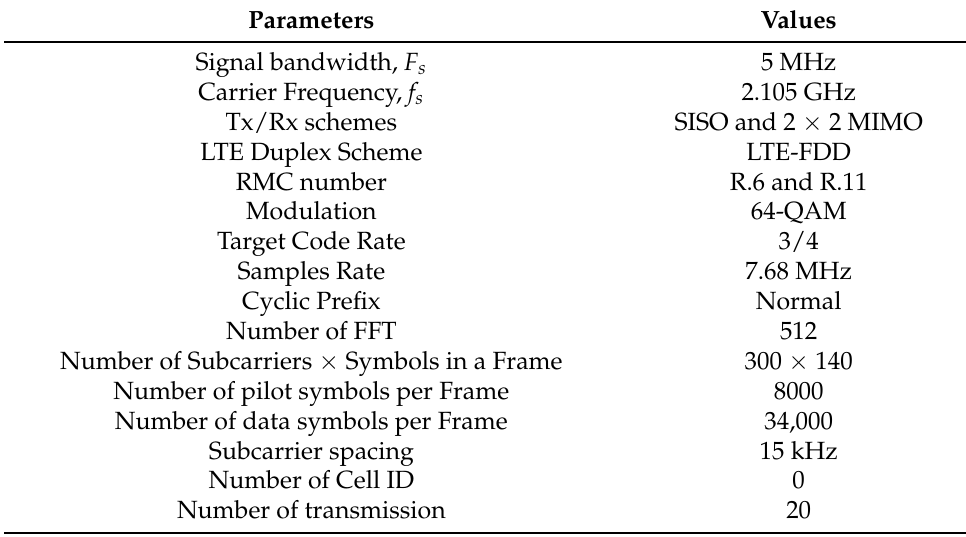
Figure 11. Indoor-to-Indoor experimental scenario with MIMO Relay Node. Table 1. Main parameters to emulate the